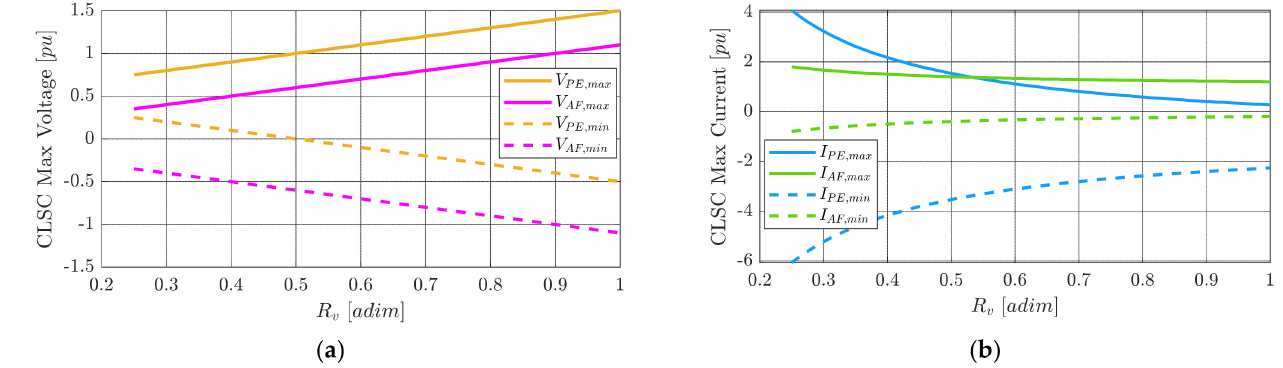
Figure 15. Open-delta CLSC max and min voltages ( a ), and max and min currents ( b ). The total SM number and the SM number divided by type and stack are shown in Figure 16.